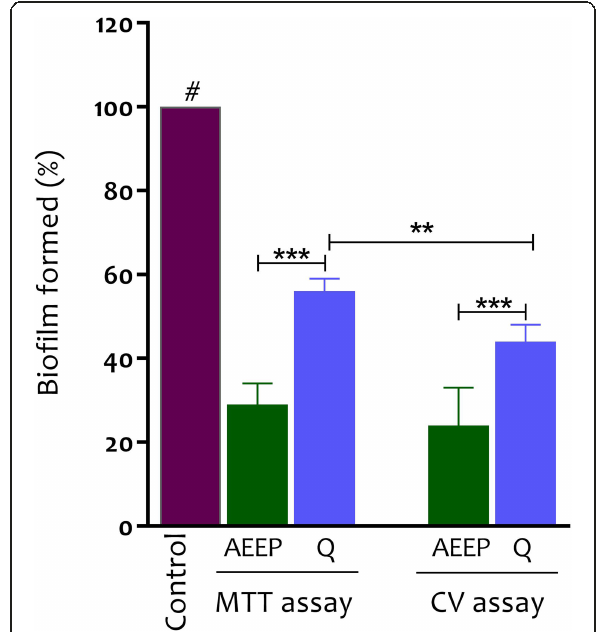
Fig. 2 Effect of AEEP (6 μ g/ml) and Q (20 μ g/ml) on the biofilm formation at 24 h of growth phase of Streptococcus mutans (ATCC 35668) at sub-MIC level. The data represent an average of triplicate experiments ± SD ( n = 3) and *** p < 0.001 and ** p < 0.01 indicated in compare between samples. # The all treatments had significant difference in compare with the untreated control ( p <